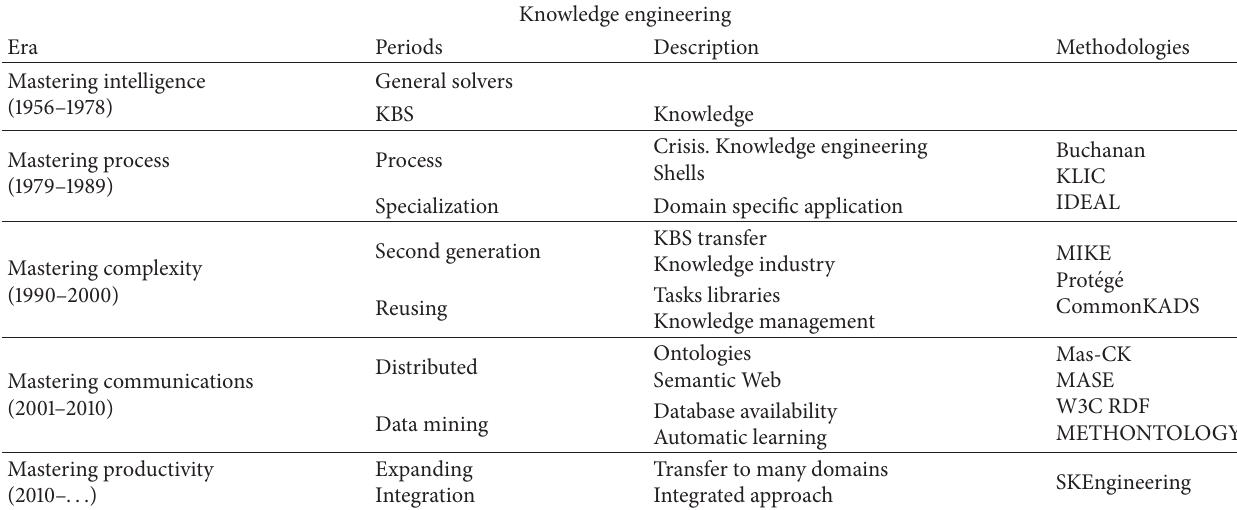
Table 3: Knowledge engineering